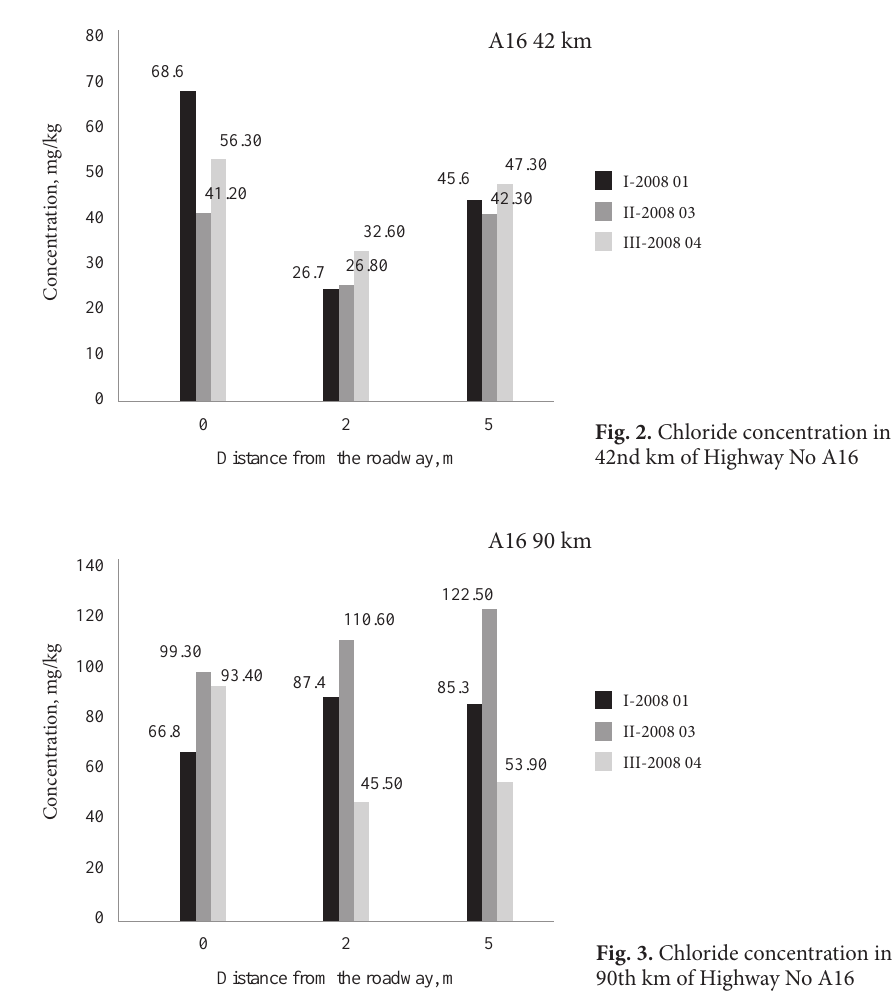
fig. 2. Chloride concentration in soil at 42nd km of Highway No A16